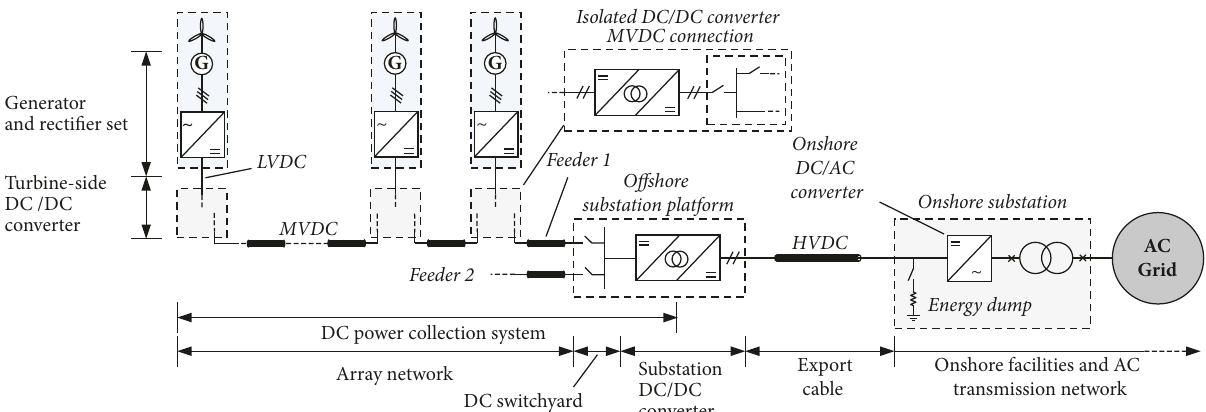
Figure 1: Generic configuration of the wind power plant with MVDC power collection.